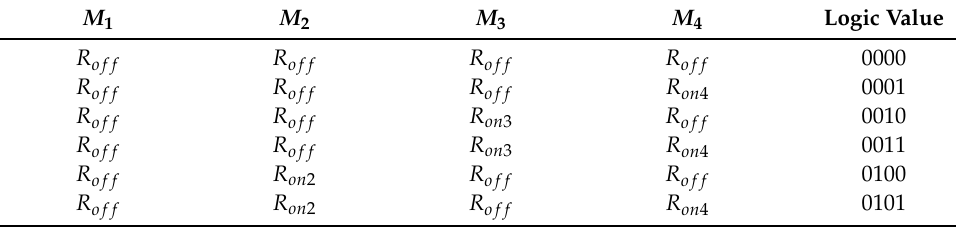
Figure 3. The relationship between voltage and current of M 1 , M 2 , M 3 , and M 4 . Table 1. Sixteen logical values corresponding to the memory